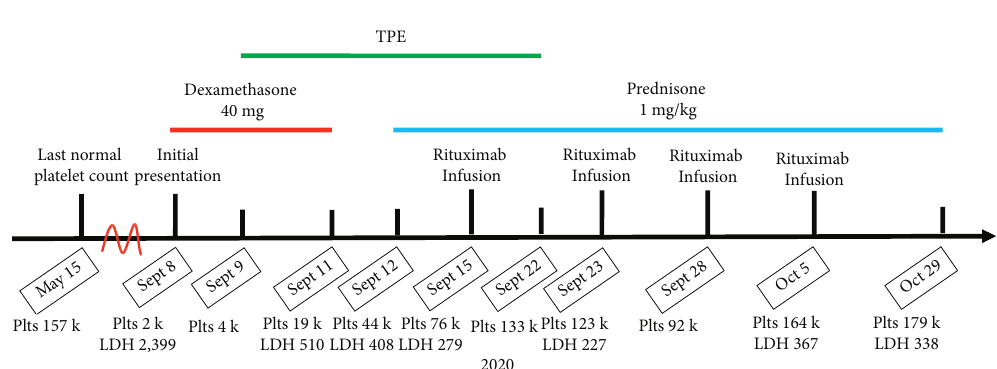
Figure 2: TTP diagnosis and treatment timeline. Major dates in patient’s TTP presentation and treatment course occurring in 2020 are listed along the x -axis with accompanying hash marks and events above. The red scale break on the x -axis signifies large relative gap in time between dates. Daily platelet counts (/ µ L) and LDH (U/L) where available are listed below respective dates. The above timeline includes major therapies with which the patient was treated, spanning across dates received including dexamethasone 40mg (red bar), prednisone 1mg/kg (blue bar), and plasma exchange (TPE, green bar). Overlapping bars imply multiple treatments given on same days.